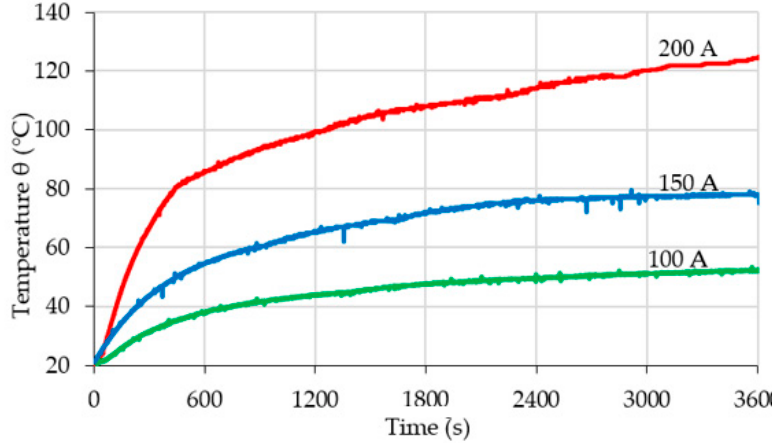
Figure 9. Temperature variation from the contact area by impedance bond and one steel conductor at di ff erent currents (100 A, 150 A, 200 A).